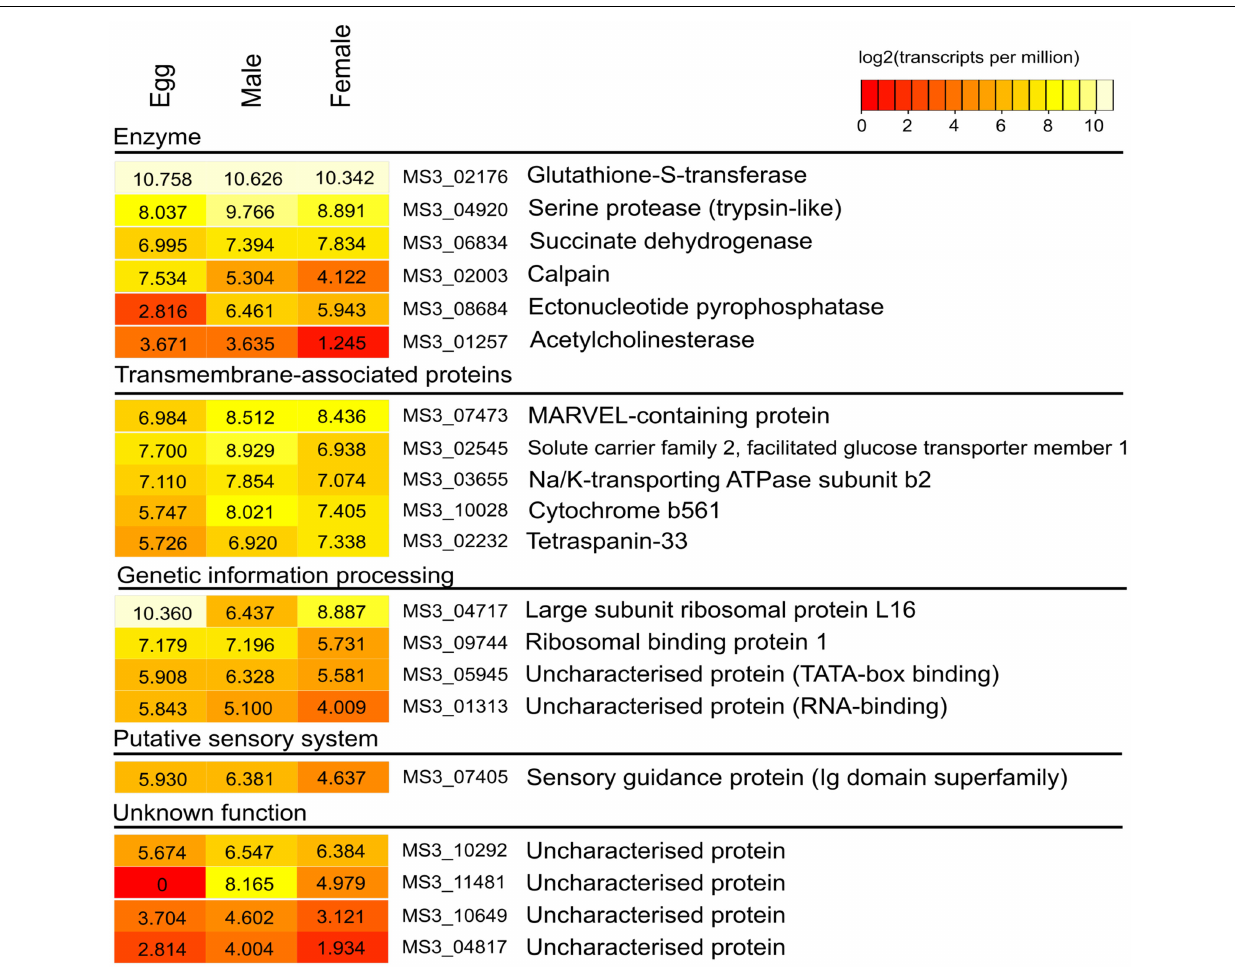
FIGURE 5 | Gene transcription in the adult and egg stages of S. haematobium for all arrayed proteins inducing significantly different and reactive IgG responses to DIR post-treatment sera . Data were assembled from publicly available RNA-seq databases (43). These data were filtered for quality (PHRED score of > 30) using Trimmomatic (8) and aligned to the open